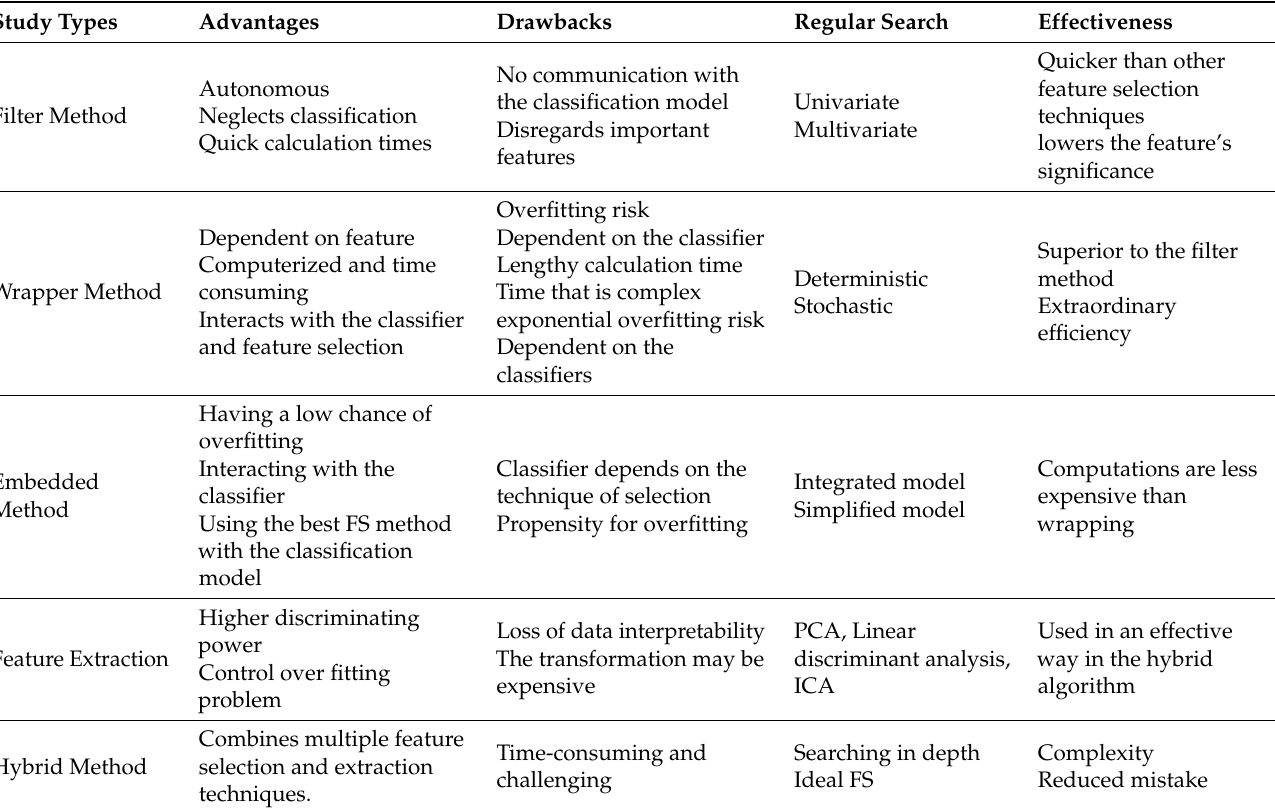
Table 1. Comparison of different dimension reduction